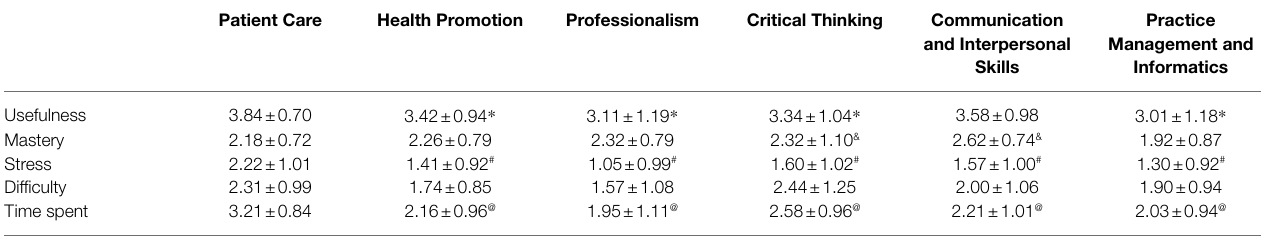
TABLE 5 | Self-evaluation of clinical competence among intern dentists.